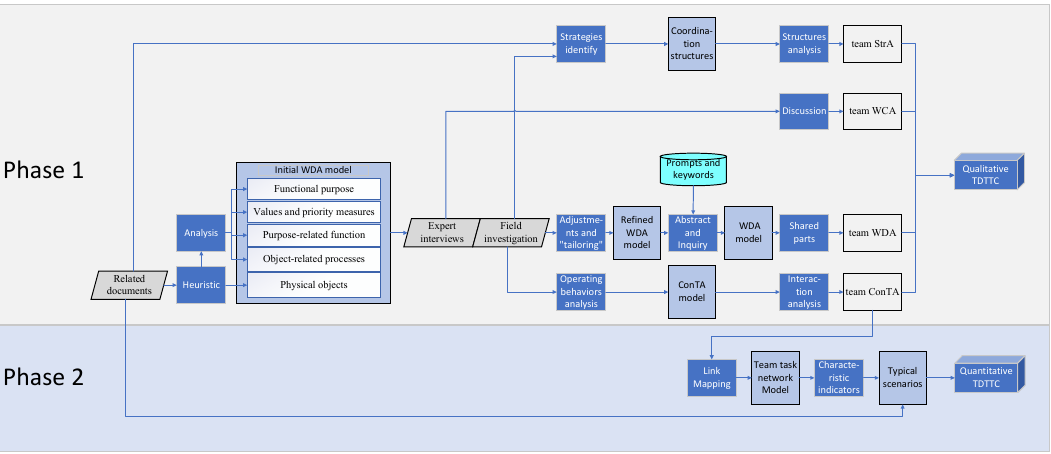
Figure 1. The build process of the TDTTC method. Different graphs are used in the method to represent different concrete processes. The grey diamond represents the data collection method, the dark blue rectangle represents the processing step, the light blue rectangle represents the intermediate part of the model, the white rectangle represents the four levels of team-CWA, and the blue cylinder represents the prompts and keywords used during the abstraction-level modeling. Details are provided below.